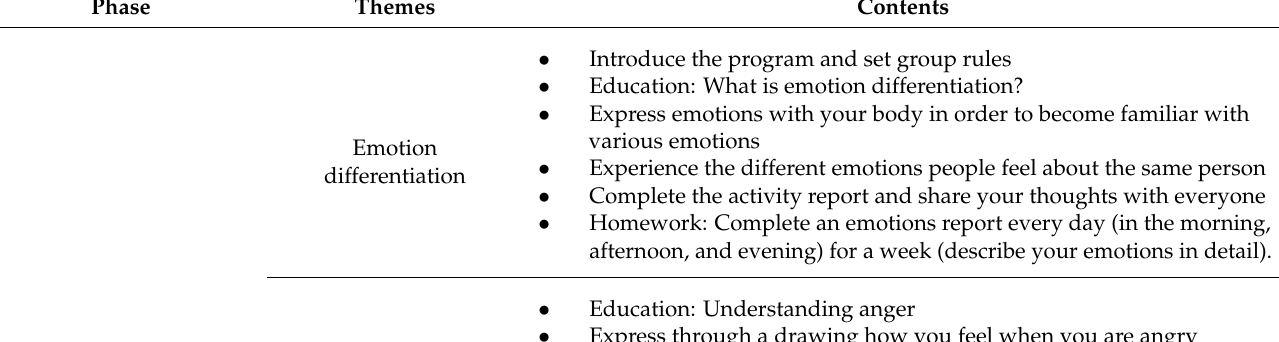
Table 1. Program contents of the anger self-control program